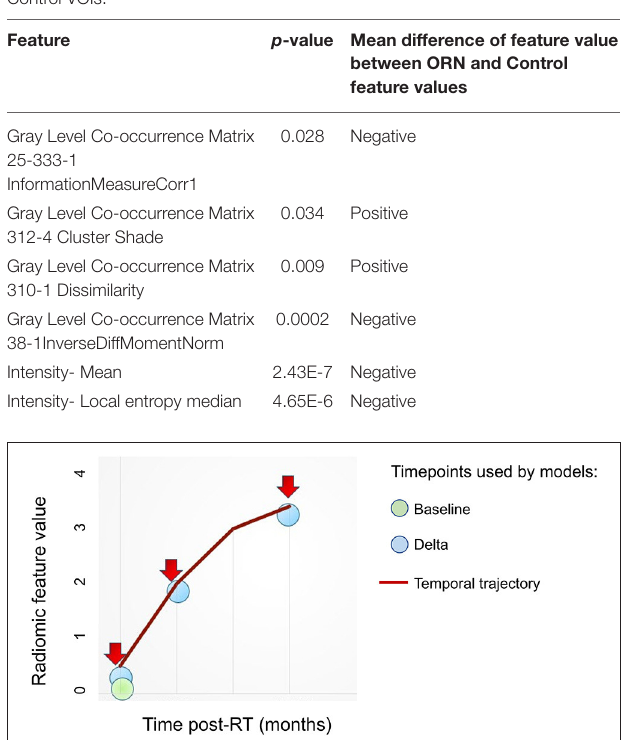
TABLE 3 | A comparison of the Areas under the curves (AUCs) and the 95% confidence intervals for the various